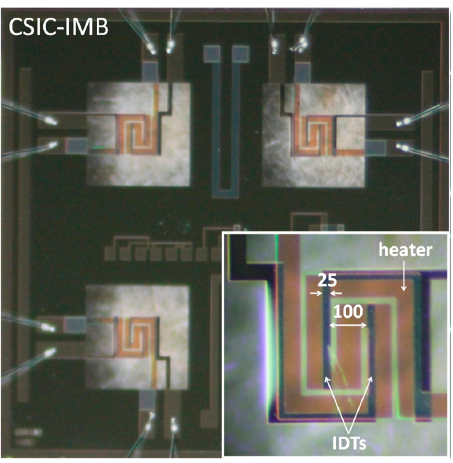
Figure 2. Silicon substrates with four microhotplates manufactured by CSIC-IMB. Insert (bottom right) show features of microhotplates: membrane, IDTs and heater (dimensions in µm).